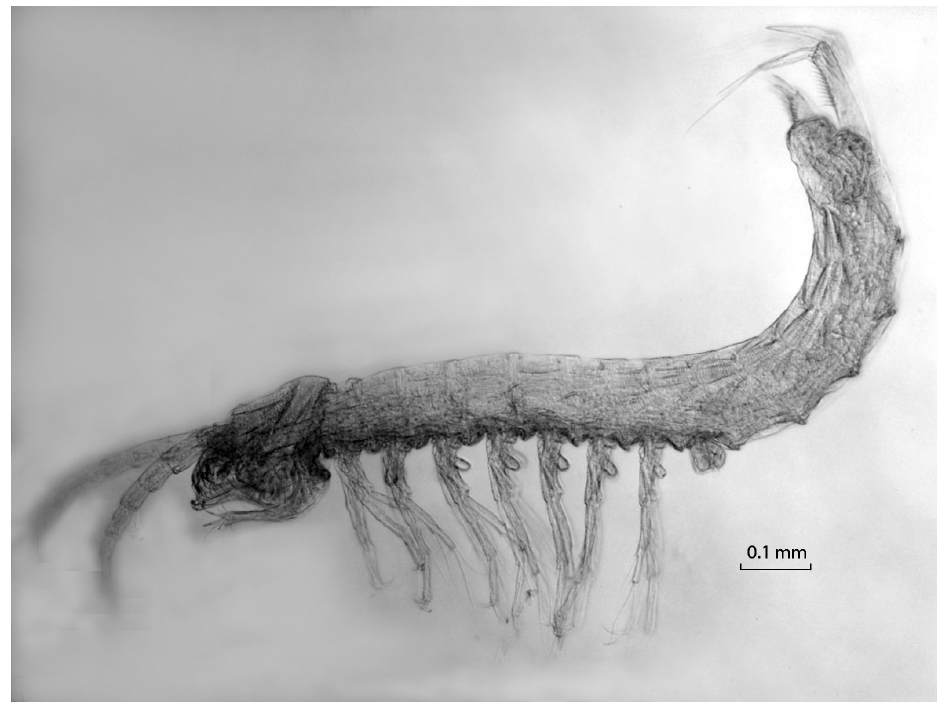
Figure 7. Habitus of Iberobathynella burgalensis Camacho,